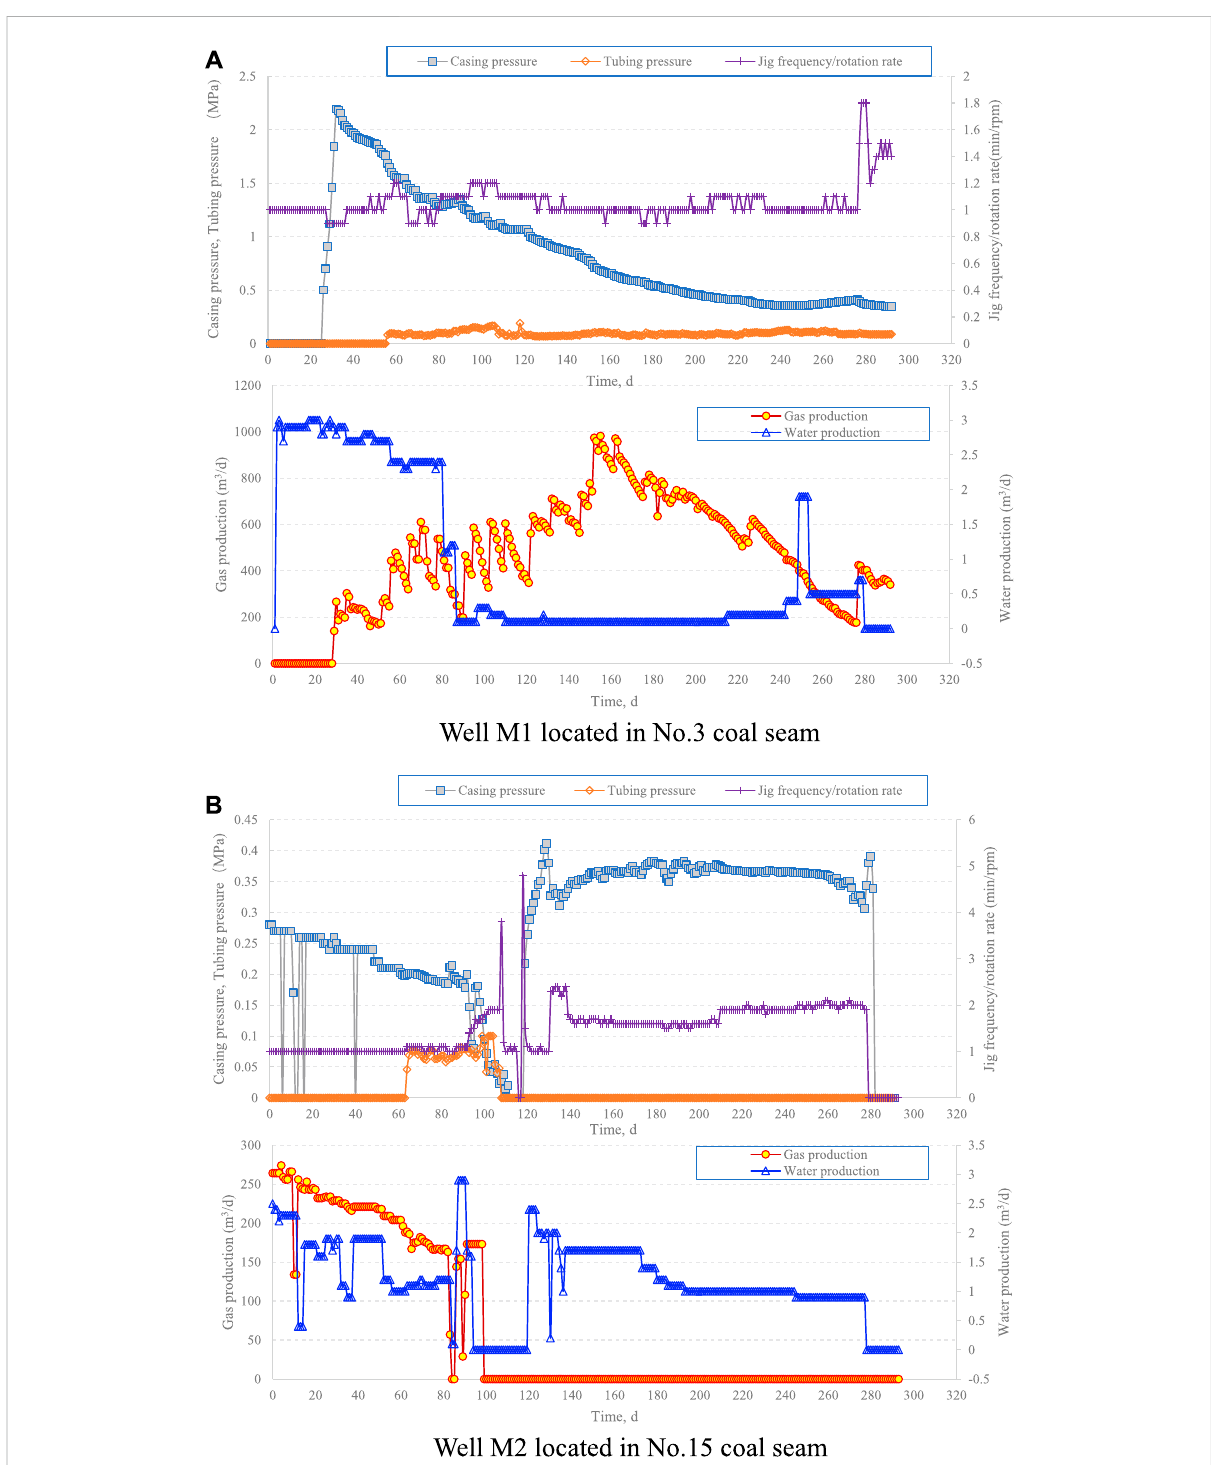
FIGURE 10 Production curves of the